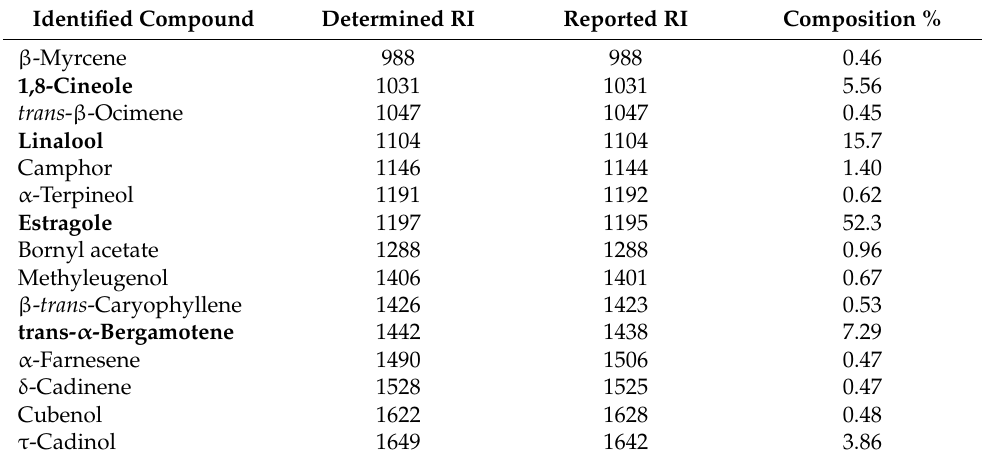
Table 1. Chemical composition of O. basilicum essential oil determined by GC–MS analysis.